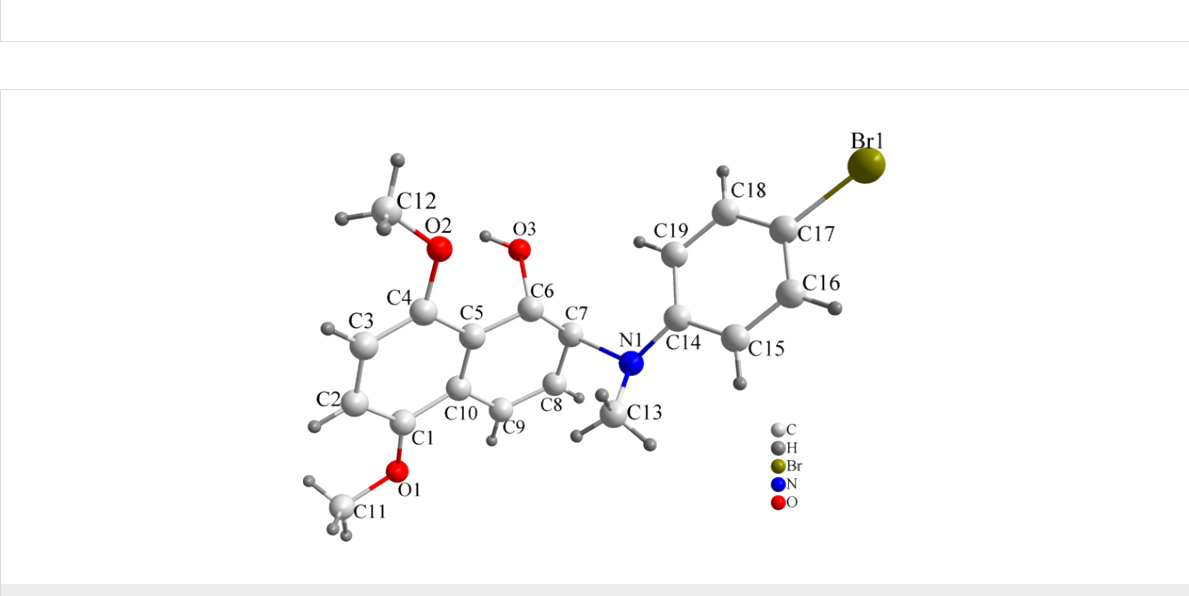
Figure 1: ORTEP plot for 3f